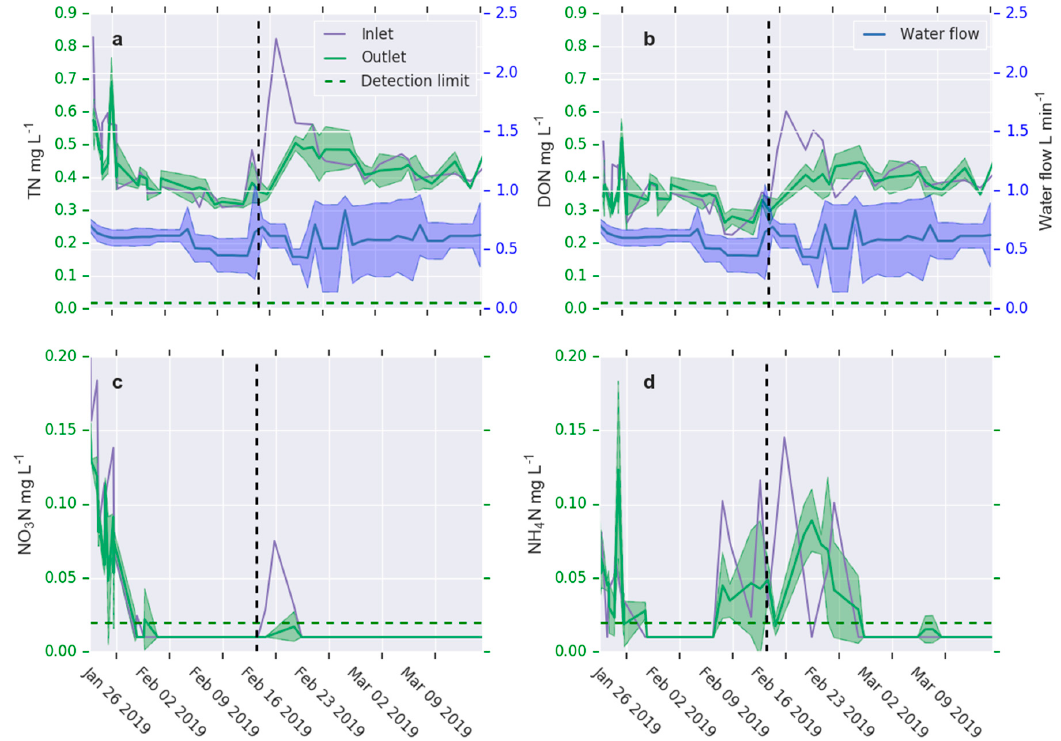
Figure 2. Total nitrogen ( a ), dissolved organic nitrogen ( b ), nitrate nitrogen ( c ), and ammonium nitrogen ( d ) in the column inlet (purple line) and outlet (green line). Mean ± standard deviation of outlet concentration is shown as green area. Mean ± standard deviation of water flow through the columns are shown as blue line and area. The vertical dashed black line represents the time of water addition to the laboratory tank and the horizontal dashed green line represents the detection limit. Time interval between the ticks is 1 week.